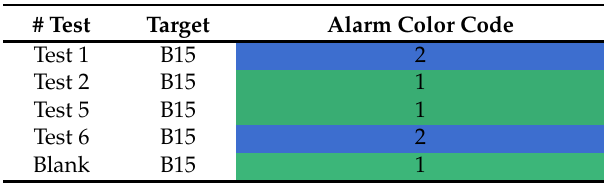
Figure 5. Raman spectra pretreated by means of linear detrend. Table 13. Results of the analysis of the spectra pretreated by linear